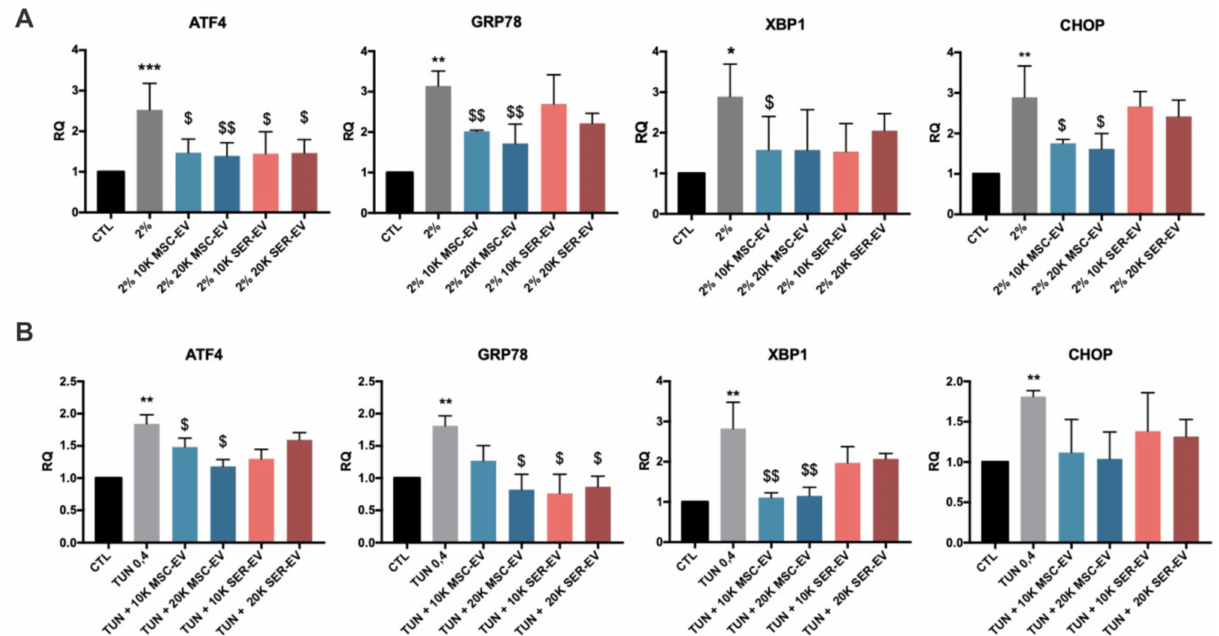
Figure 4. Regulation of the expression of ER stress related genes. HCECs were exposed to serum starvation or tunicamycin for 24 h, and were further stimulated with MSC- or SER-EVs for 3 h. Real time analysis showing the expression of ATF4, GRP78, XBP1, and CHOP with HCECs in normal culture conditions (CTL), in serum deprivation (2%) ( A ), or treated with 0.4 ng/mL of tunicamycin (TUN 0.4) ( B ), with or without 10–20 × 10 3 MSC-EV/cell (10K/20K MSC-EV) or 10–20 × 10 3 SER-EV/cell (10K/20K SER-EV). GAPDH was used as an endogenous normalizer. Data were further normalized to CTL, set as 1, and used as a reference sample for each experiment. The graphs show the RQ average (2 − ∆∆ Ct ) of at least three independent experiments ± SD. One-way ANOVA with Tukey’s multiple comparisons test was performed after the normalization of each experiment to CTL; * p < 0.05, ** p < 0.01, and *** p < 0.0001 with respect to CTL, $ p < 0.05, $$ p < 0.01 vs. 2% ( A ) or TUN ( B